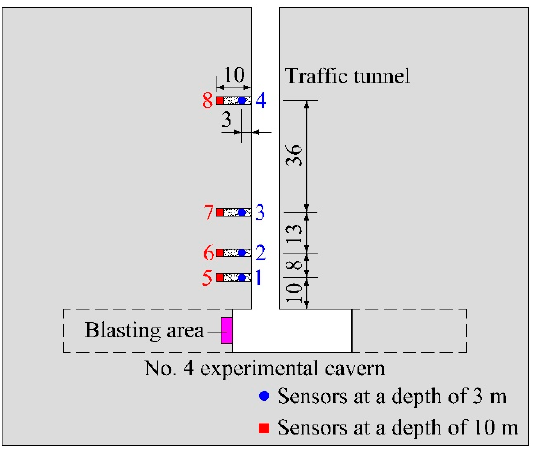
Figure 12. Arrangements of monitoring for blast-induced seismic waves (unit: m).